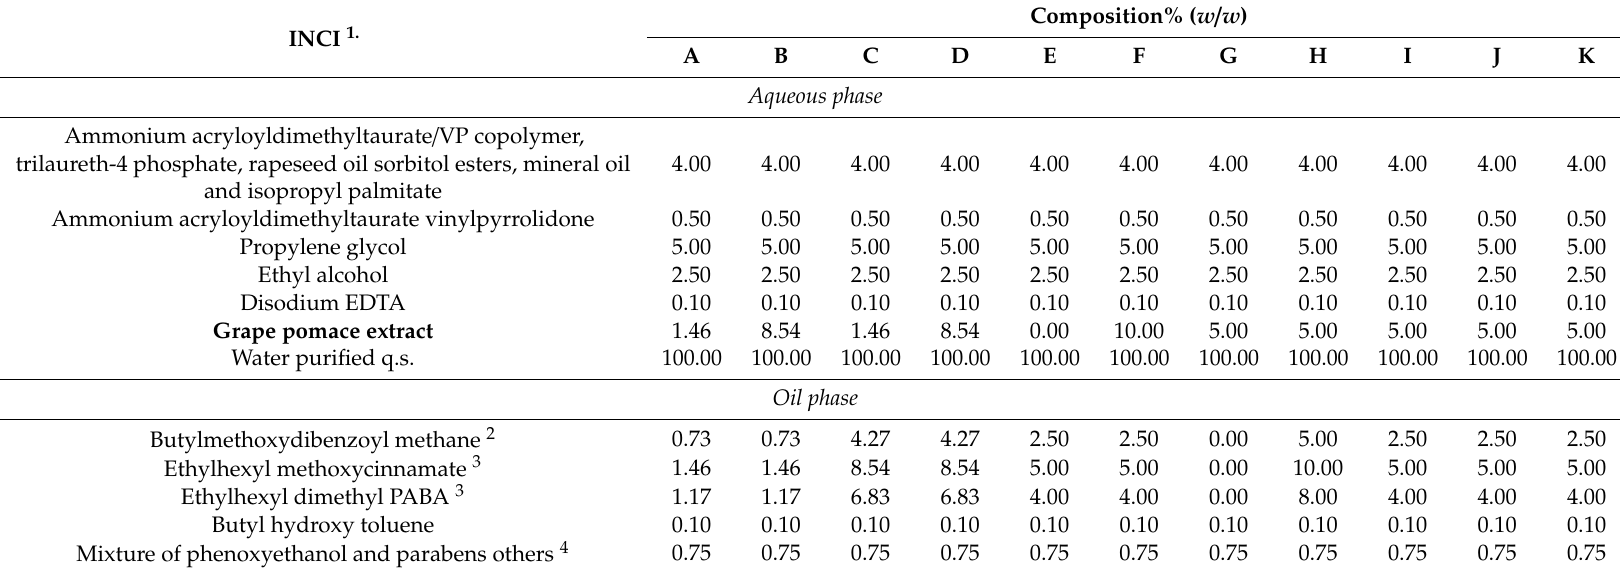
Table 1. Active and bioactive ingredients (% w / w ) used in sunscreens formulations of dried grape pomace ( V. vinifera L.) and UV filters. INCI